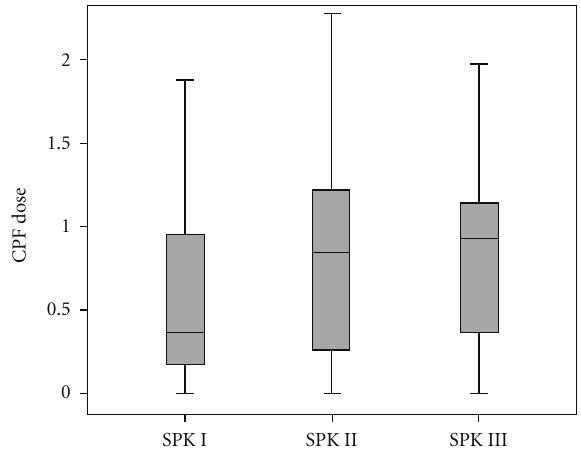
Figure 3: The dose estimates (CPF DOSE, µ g/kg/day) for chlor- pyrifos using urinary 3,5,6-trichlorpyridinol concentrations in three di ff erent spot urine sample composite methods; SPK I, SPK II, and SPK